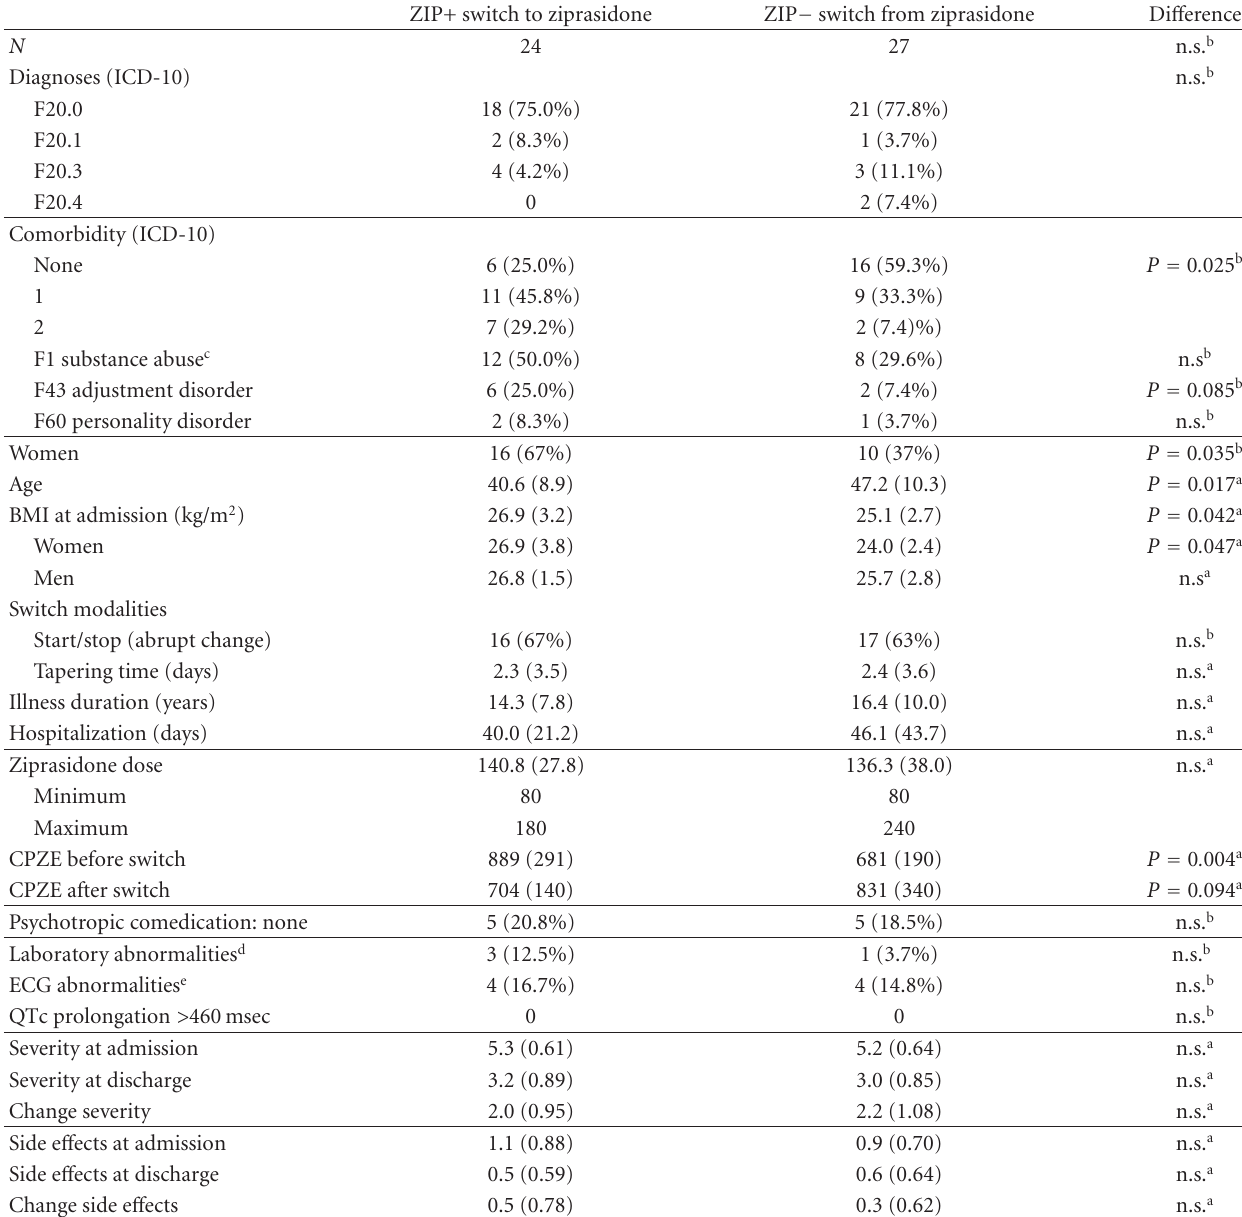
Table 1: Switch from or to ziprasidone: clinical